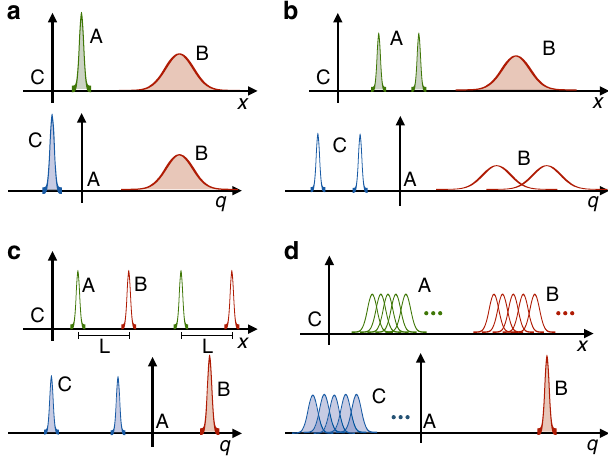
Fig. 3 Examples of relative states in different quantum reference frames. The relative states are described from the reference frame of C (above in each sub fi gure) and A (below in each sub fi gure) in the position basis. Product states are represented as curves whose area is shaded, while entangled states as curves whose area is not shaded. In a A ’ s state is well- localised from the point of view of C. In A ’ s reference frame, B has the same state as seen from C, but translated, and C is well-localised. This case corresponds to the translation of a classical reference frame. In b A and B are in a product state, and A is in a superposition of two sharp-position states that do not overlap. From A ’ s point of view B and C are entangled, but the relative distance between the states is unchanged. In c A and B